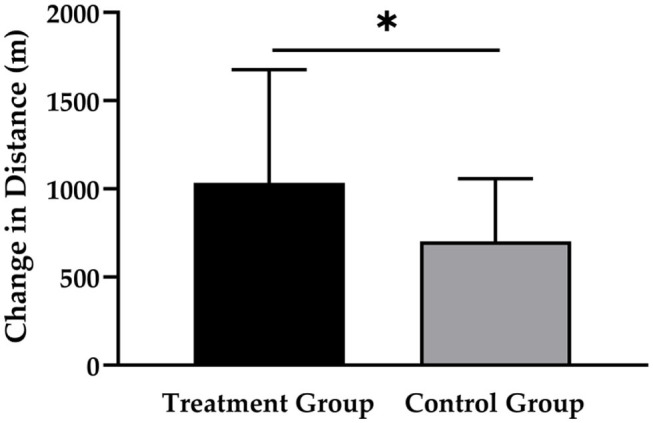
Changes in running distance after 12 weeks of intervention in treatment group (n = 28) and control group (n = 31). Values are means ± SD for n subjects. *Significantly different (p < 0.05) by repeated-measures ANOVA (time × group interaction).